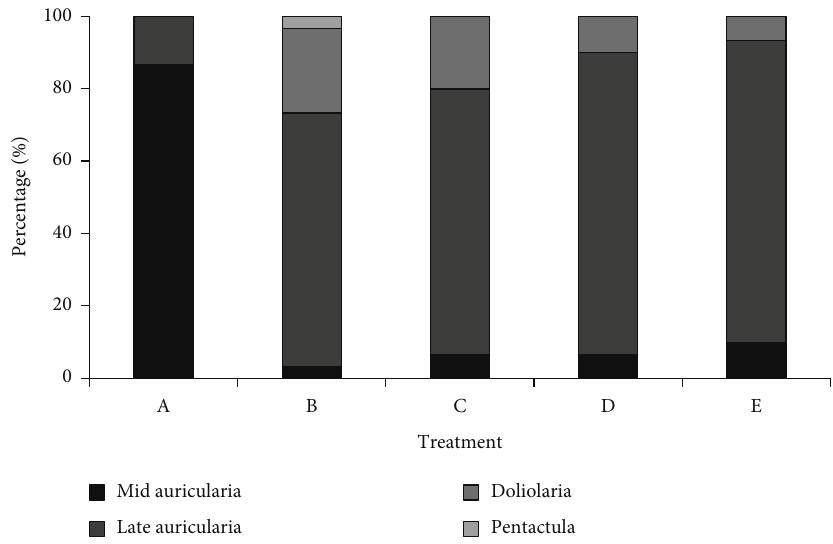
Figure 3: Proportional composition of Holothuria leucospilota larval stages in di ff erent diet treatments on day 15. n = 30